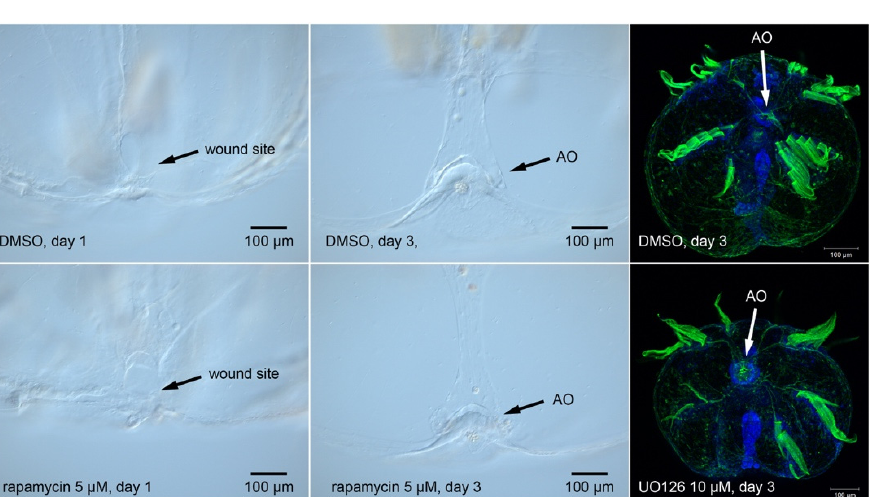
Figure 5. The TOR pathway inhibitor rapamycin and the MEK pathway inhibitor UO126 do not prevent regeneration in the ctenophore M. leidyi . Treatment with these inhibitors does not alter the time to replacement after amputation of the aboral sense organ (apical organ). Similar negative results appear to be widely known through word of mouth but seem to have remained unpublished elsewhere, so we demonstrate them here.